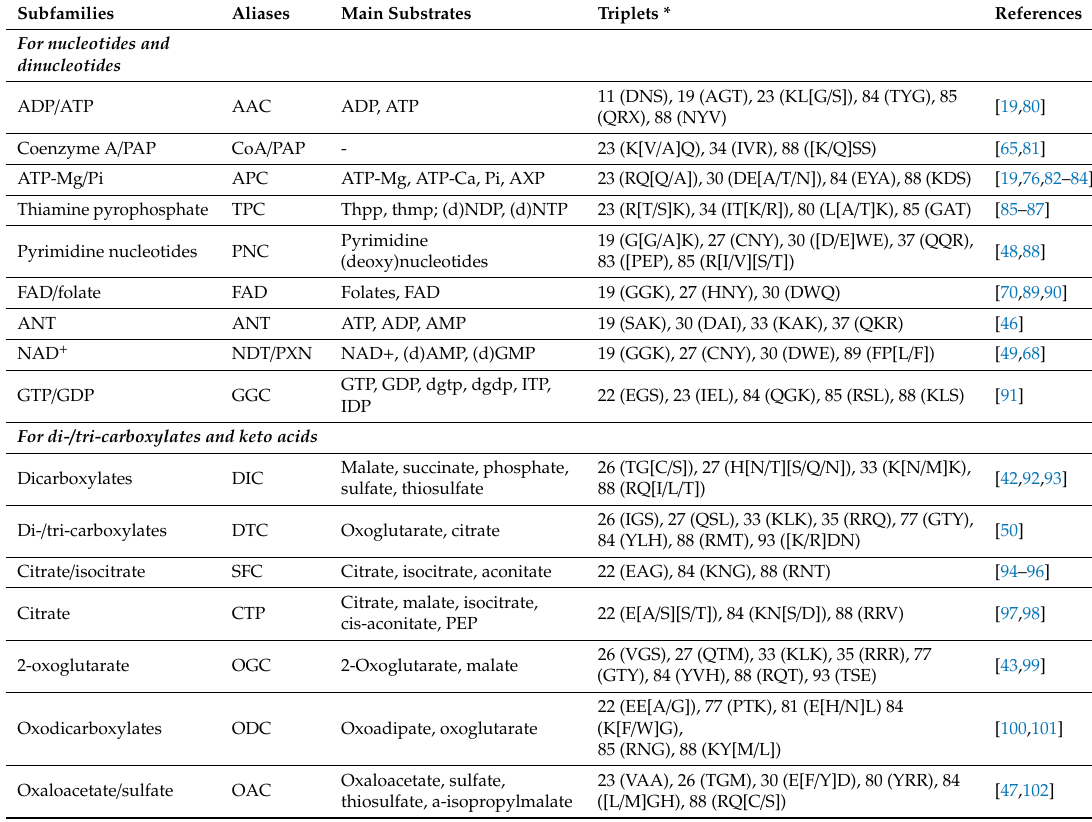
Table 2. Subfamilies of mitochondrial carrier defined by substrate